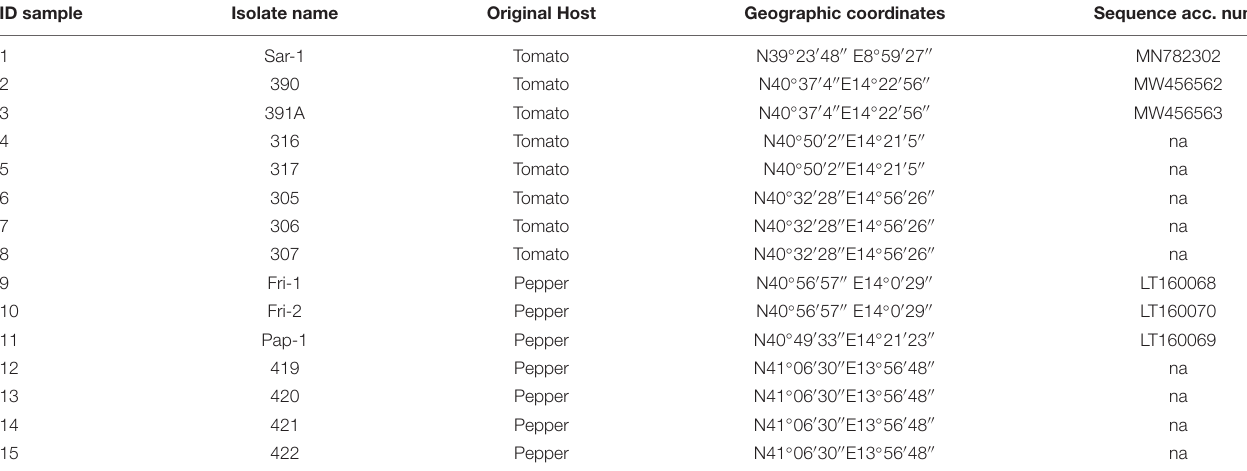
TABLE 2 | PMoV isolates used in this